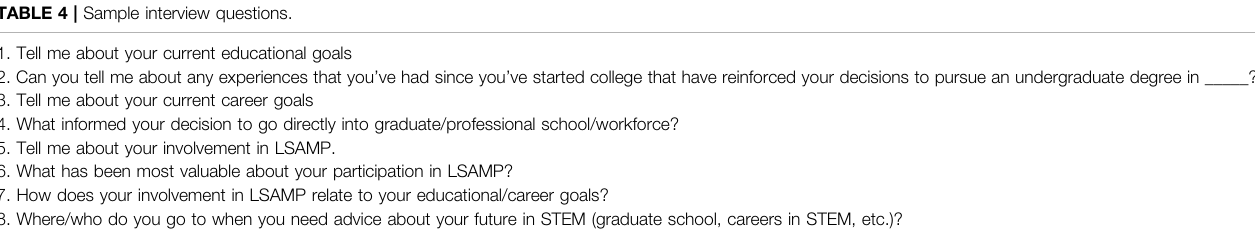
TABLE 4 | Sample interview